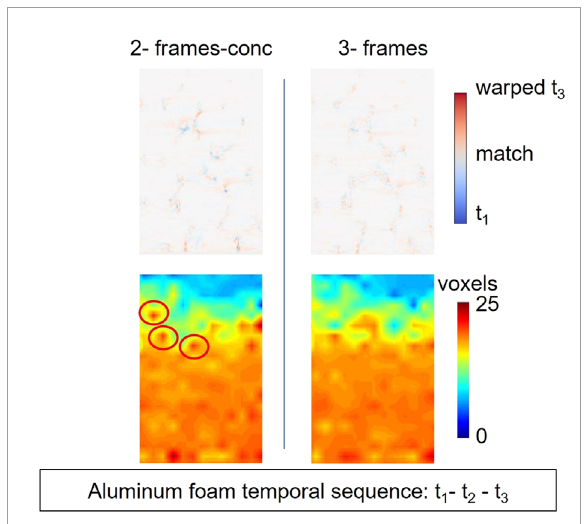
FIGURE 9 In the first row is shown the central slices of the consistency map defined by the difference between the reference and deformed volumes is shown. Red regions correspond to material of the warped t3 does not match material in t1; blue regions correspond to material of t1 does not match material in the warped t3; white regions correspond to material of warped t3 that fully overlap material in t1. In the second row the magnitude of the displacement field computed using 2-frames-conc and 3-frames in the plane y-z is shown. The red circles in the figure highlight peaks of